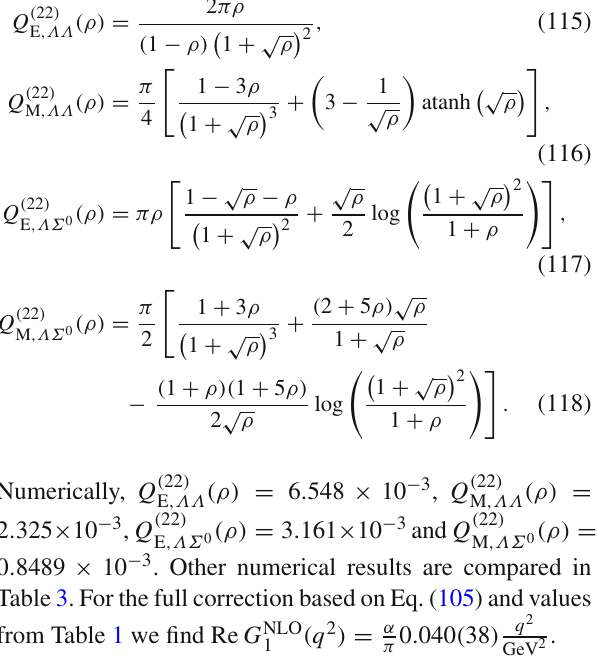
Table 3. For the full correction based on Eq. (105) and values from Table 1 we find Re G NLO